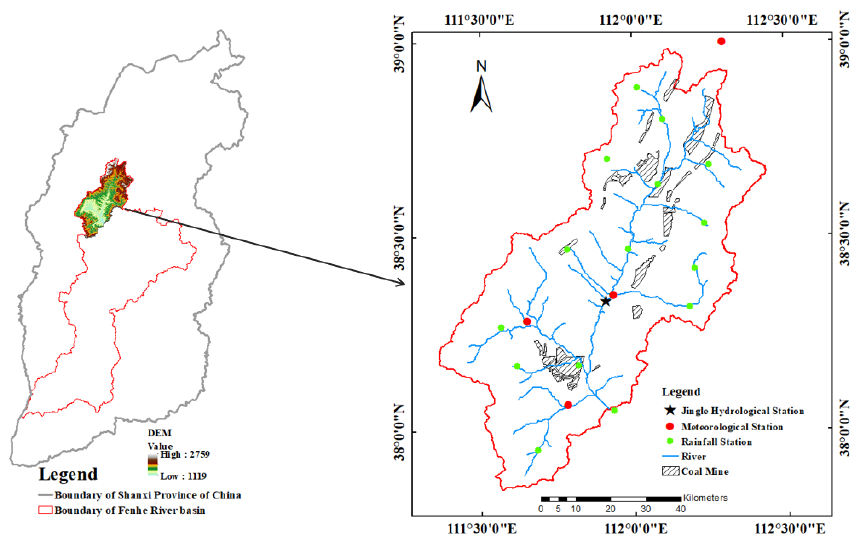
Figure 1. Location of the study area.